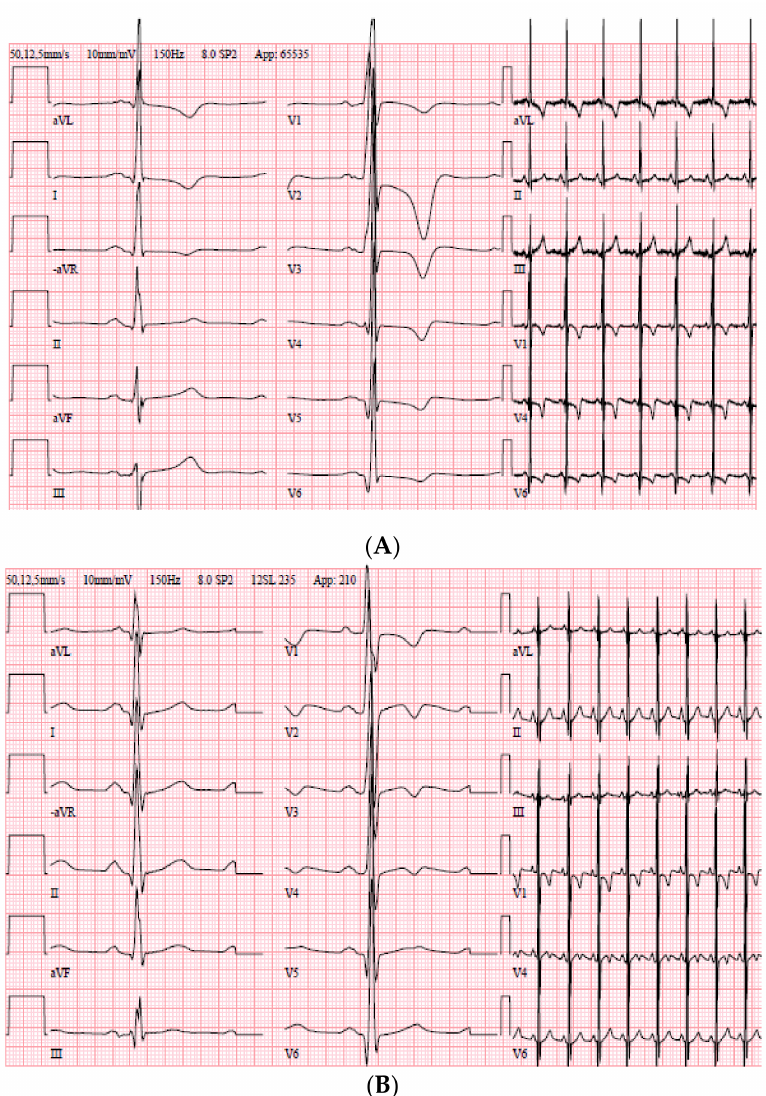
Figure 4. ECG of the index patient, Family 10. ( A ) ECG at the age of 24 years. ( B ) ECG at the age of